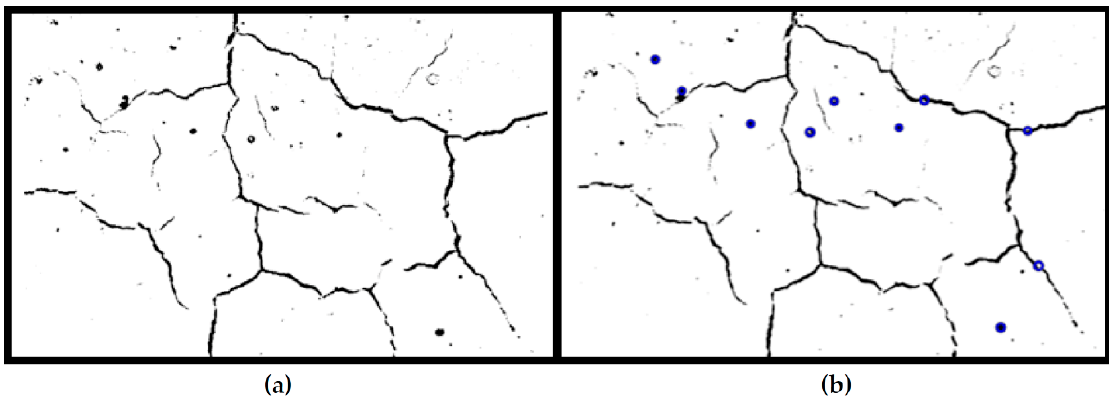
Figure 6. Binary images: ( a ) morphological operation; ( b ) dot detection.